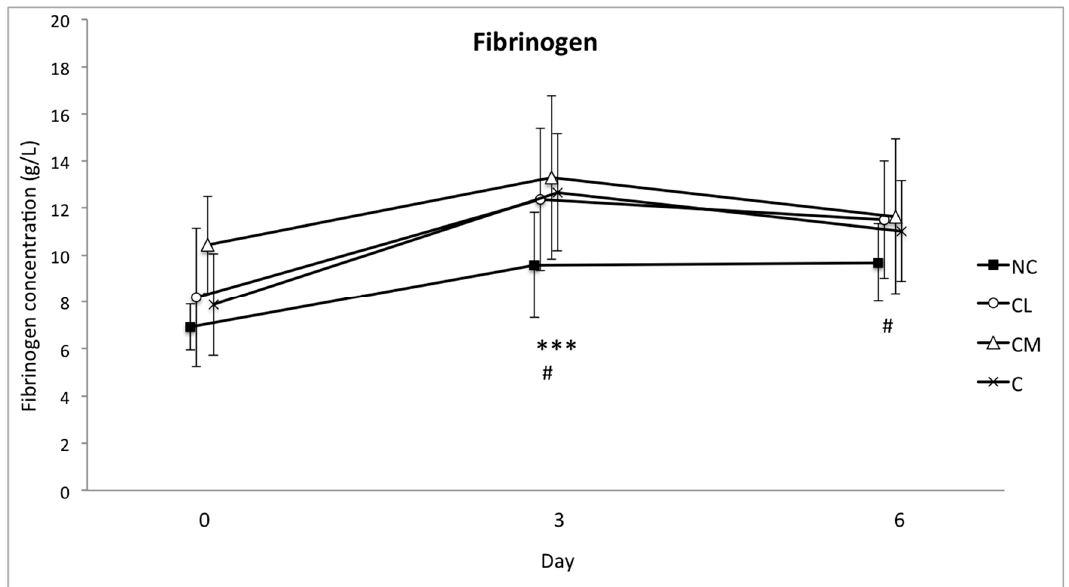
Figure 6. Mean (±SD) concentration of fibrinogen in plasma (g/L) of Bos indicus bull calves before and after surgical castration. NC = no castration, CL = castration with lidocaine, CM = castration with meloxicam, C = castration without analgesia. *** p < 0.001 difference in all groups from day 0 to day 3 and between groups on day 3. # p = 0.0003 the plasma concentration of fibrinogen was lowest in the NC group on days 3 and 6.